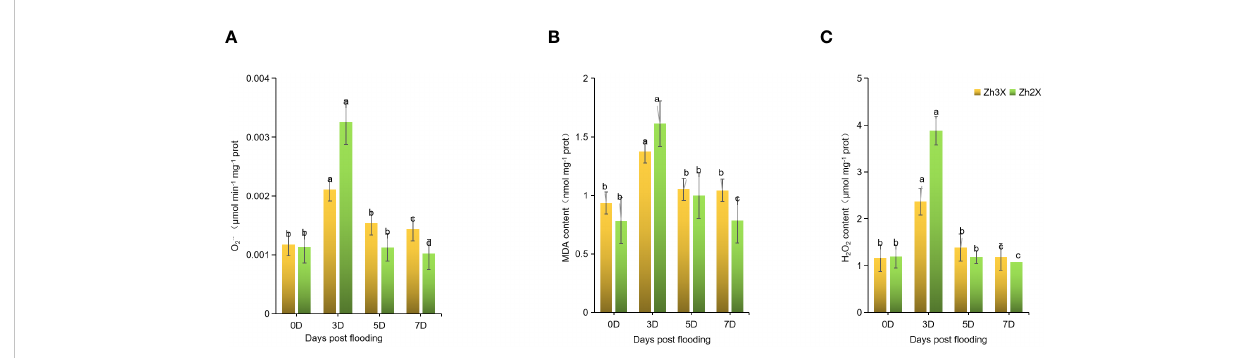
FIGURE 2 Fluctuation in O 2 : (cid:1) Production rate, H 2 O 2 , and MDA Contents. (A) O 2 : (cid:1) Production rate. (B) MDA content. (C) H 2 O 2 content. Perpendicular bars display averages ± SD (n = 6). Lower case letters above each bar present signi fi cant changes at p < 0.05 (Duncan ’ s multiple range test).